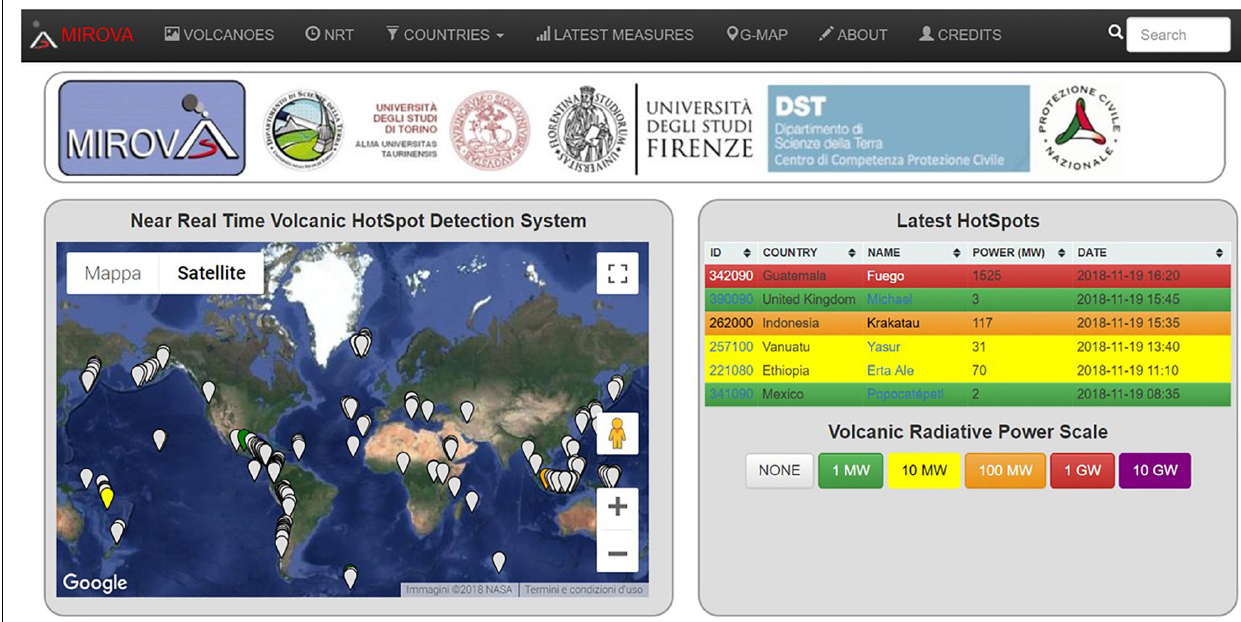
FIGURE 1 | Snapshot of the home page of the MIROVA website (www.mirovaweb.it; accessed on 19 November 2018).